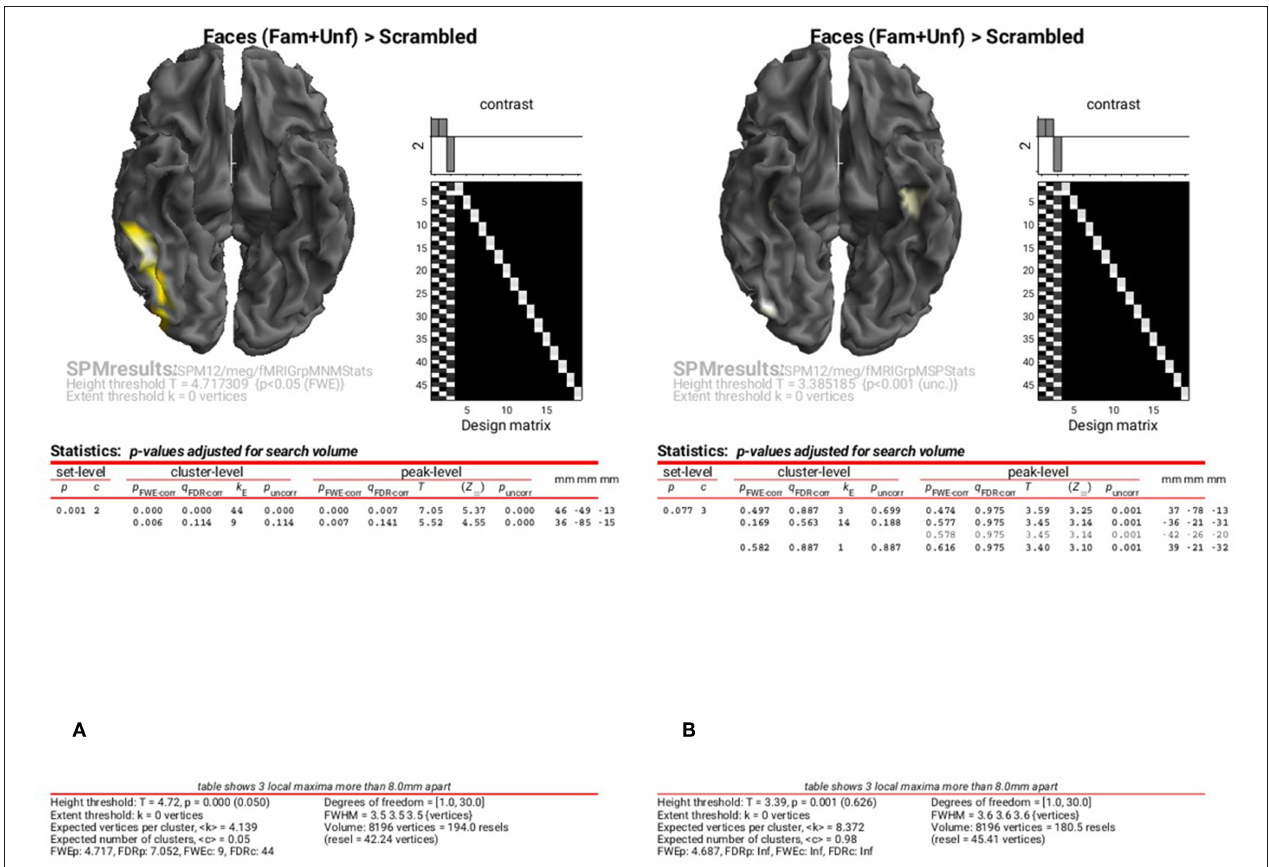
FIGURE 9 | Group SPM for Faces vs. Scrambled power on cortical mesh between 10 and 20Hz and 100 and 250ms across all 16 subjects using group-optimisation of MNM (A) and MSP (B) together with fMRI priors. (A) is thresholded at p < 0.05 FWE corrected, (B) at p < 0.001 uncorrected.